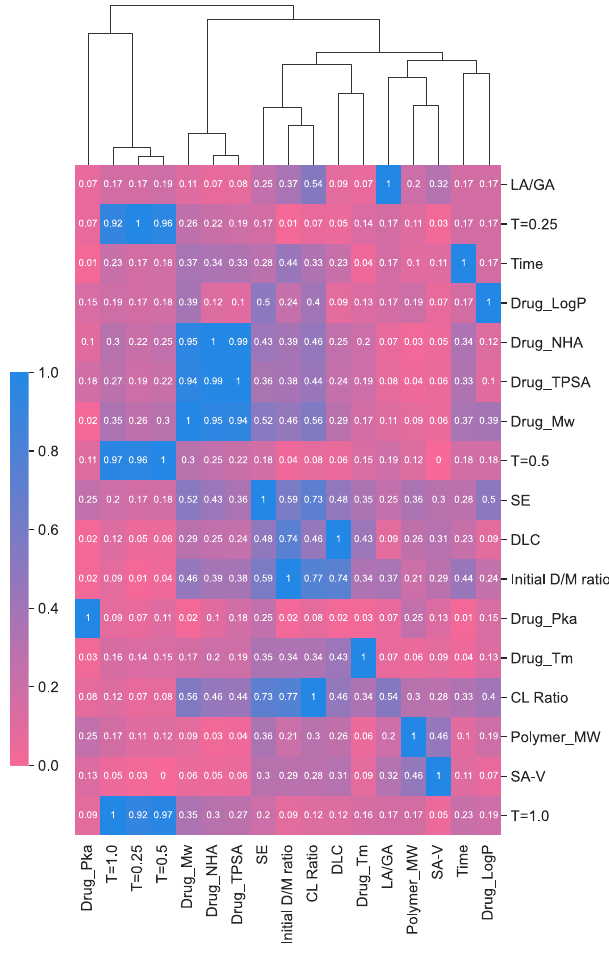
Fig. 3 | Heatmap of the absolute Spearman ’ s Rank correlation between the initial 17 input features. Dark blue signi fi es an absolute Spearman ’ s Rank corre- lation=1, and pink represents an absolute Spearman ’ s Rank correlation of 0. Attached to the heatmap is a dendrogram that displays the hierarchies of feature clusters that were determined via agglomerative hierarchical clustering analysis. Source data are provided as a Source Data fi le.